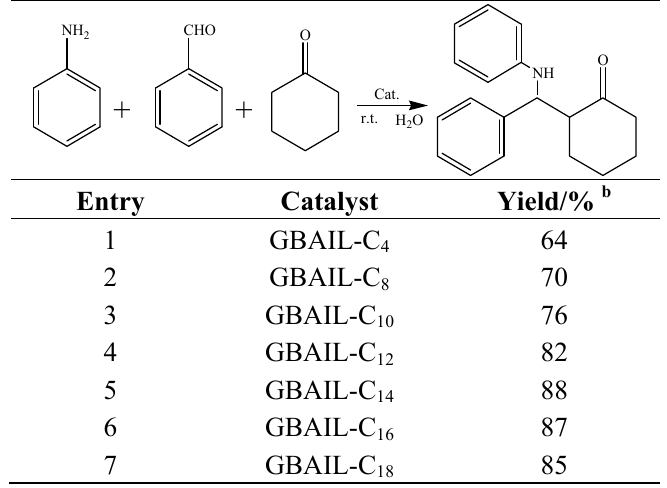
Table 1. Influence of the catalytic system on the Mannich reaction in water a .